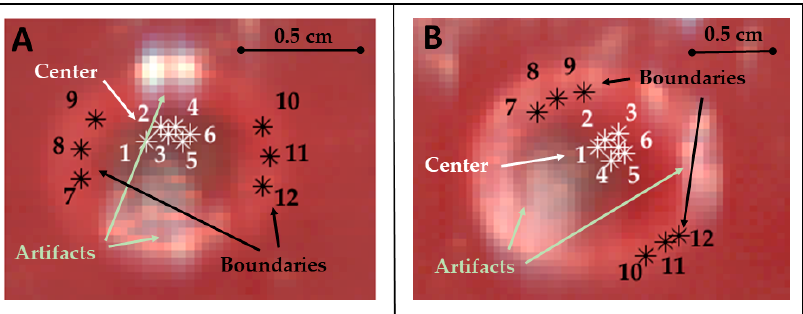
Figure 3. Pixels of the center and boundary of the lesion selected for studying the area under the spectral curves (spectral integrals) in Test 1 ( A ) and Test 2 ( B ). Pixels were selected in zones not affected by artifacts. Positions chosen for these pixels are highlighted using RGB images collected by the HS camera at the end of the treatment and showing the thermal damage.